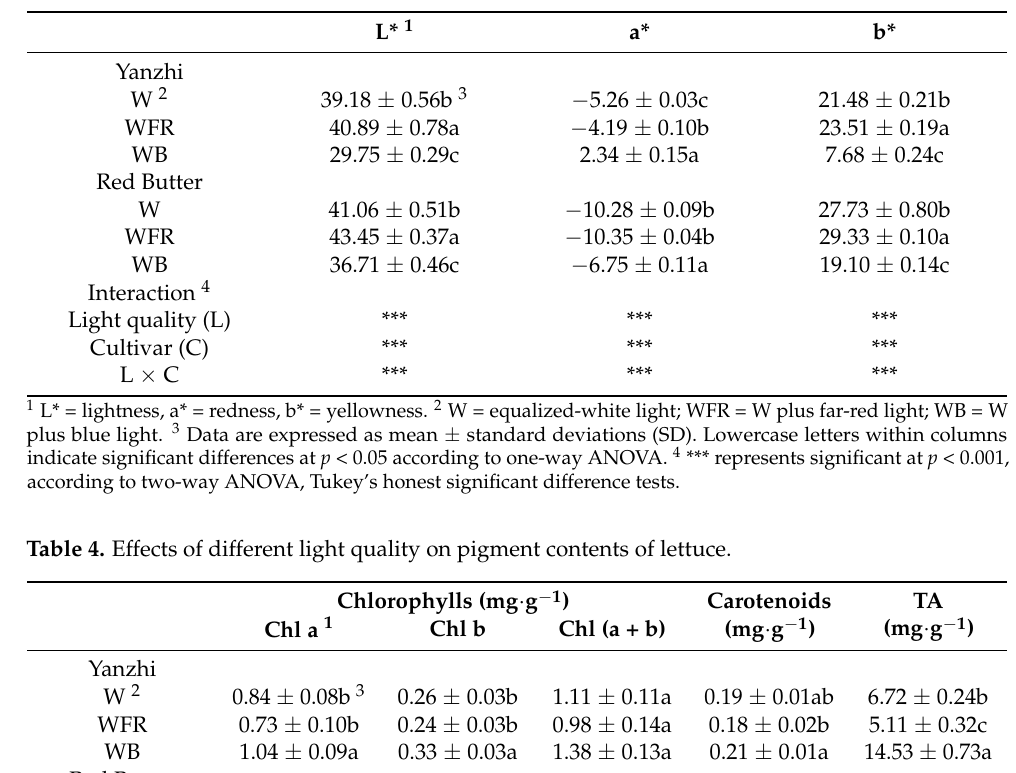
Table 3. Effects of different light quality on color parameters of lettuce.